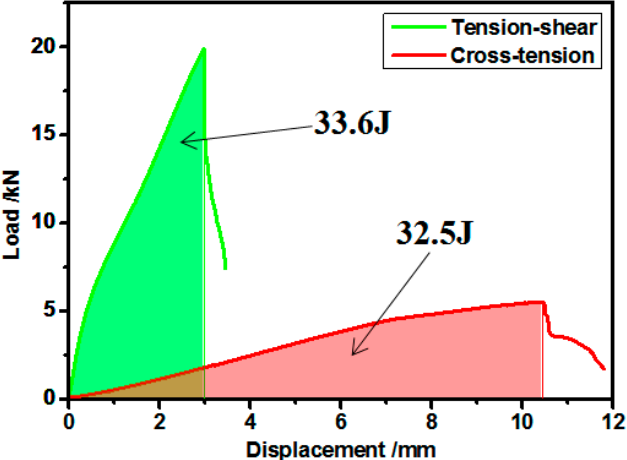
Figure 8. The load-displacement of the resistance welded MS1400 steel joints produced by 4 kN welding force and 8 kA welding current and 320 ms welding time.